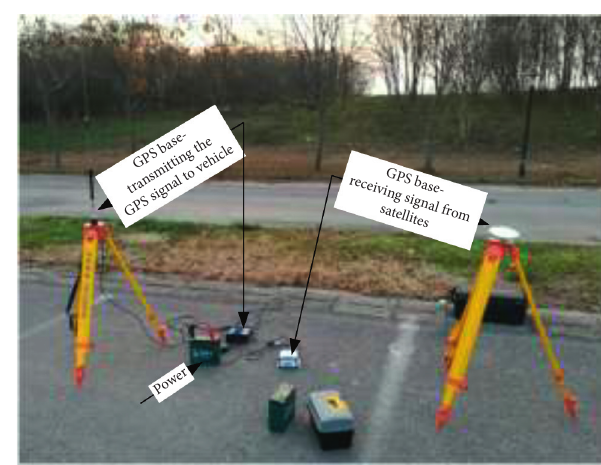
Figure 3: The GPS/IMU